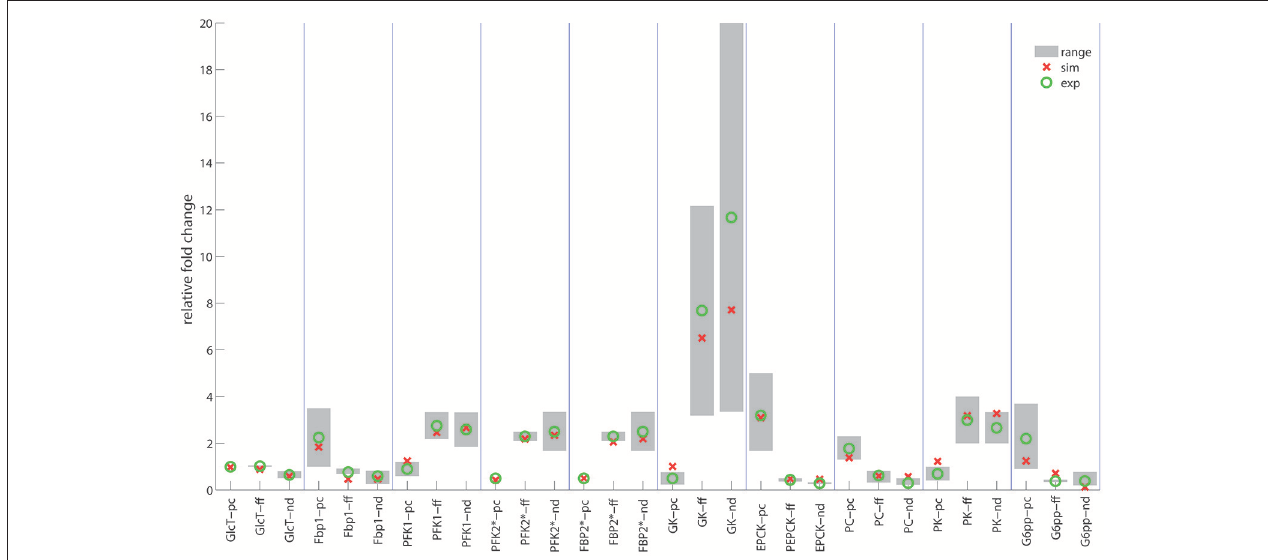
FIGURE 5 | Ratio of enzyme levels in hepatocytes. Red circles indicate the computed ratio of protein levels. Green circles and gray bars indicate the mean value and the range of variability of various experimentally determined ratios. First columns (pc): Portal-to-central ratios ( = 24h-averaged protein levels between hepatocyte #1 and hepatocyte # 25) for the well-fed state of the rat. Experimental data were taken from ( Sharma et al., 1964; Katz et al., 1977a,b; Trus et al., 1980; Jungermann and Katz, 1982, 1989; Probst et al., 1982; Teutsch and Lowry, 1982; Miethke et al., 1985; Quistorff, 1985; Wölfle and Jungermann, 1985; Morselt et al., 1987; Chen